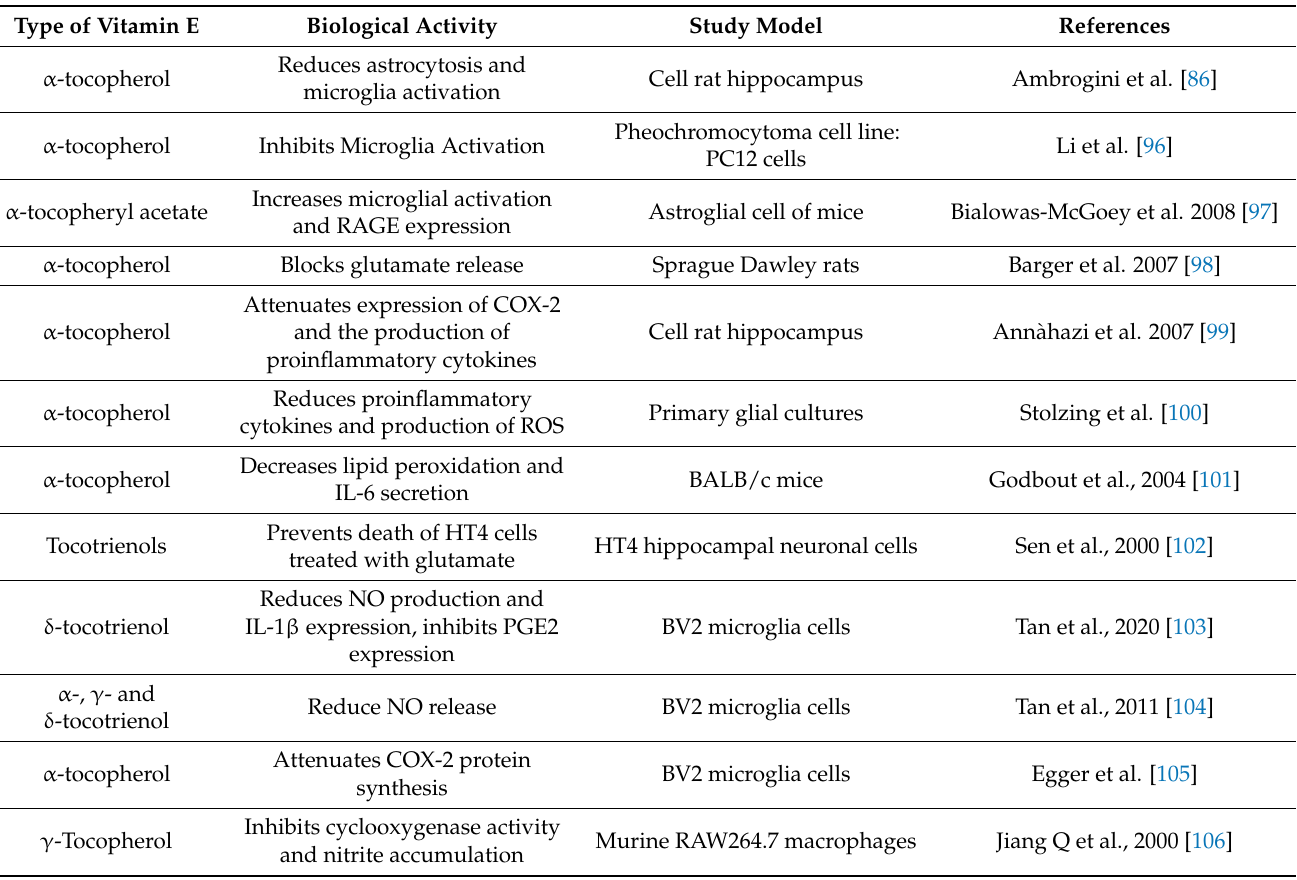
Table 1. Biological activities of each type of vitamin